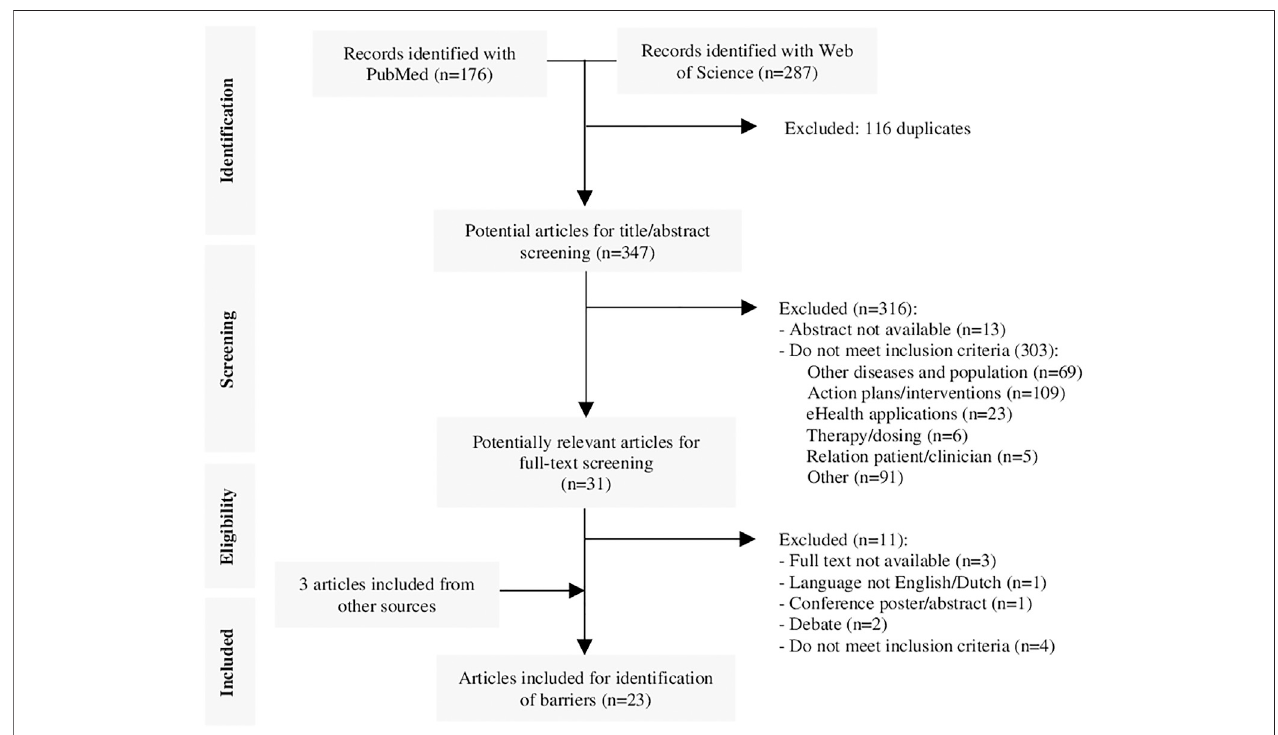
FIGURE 1 | Systematic literature review fl